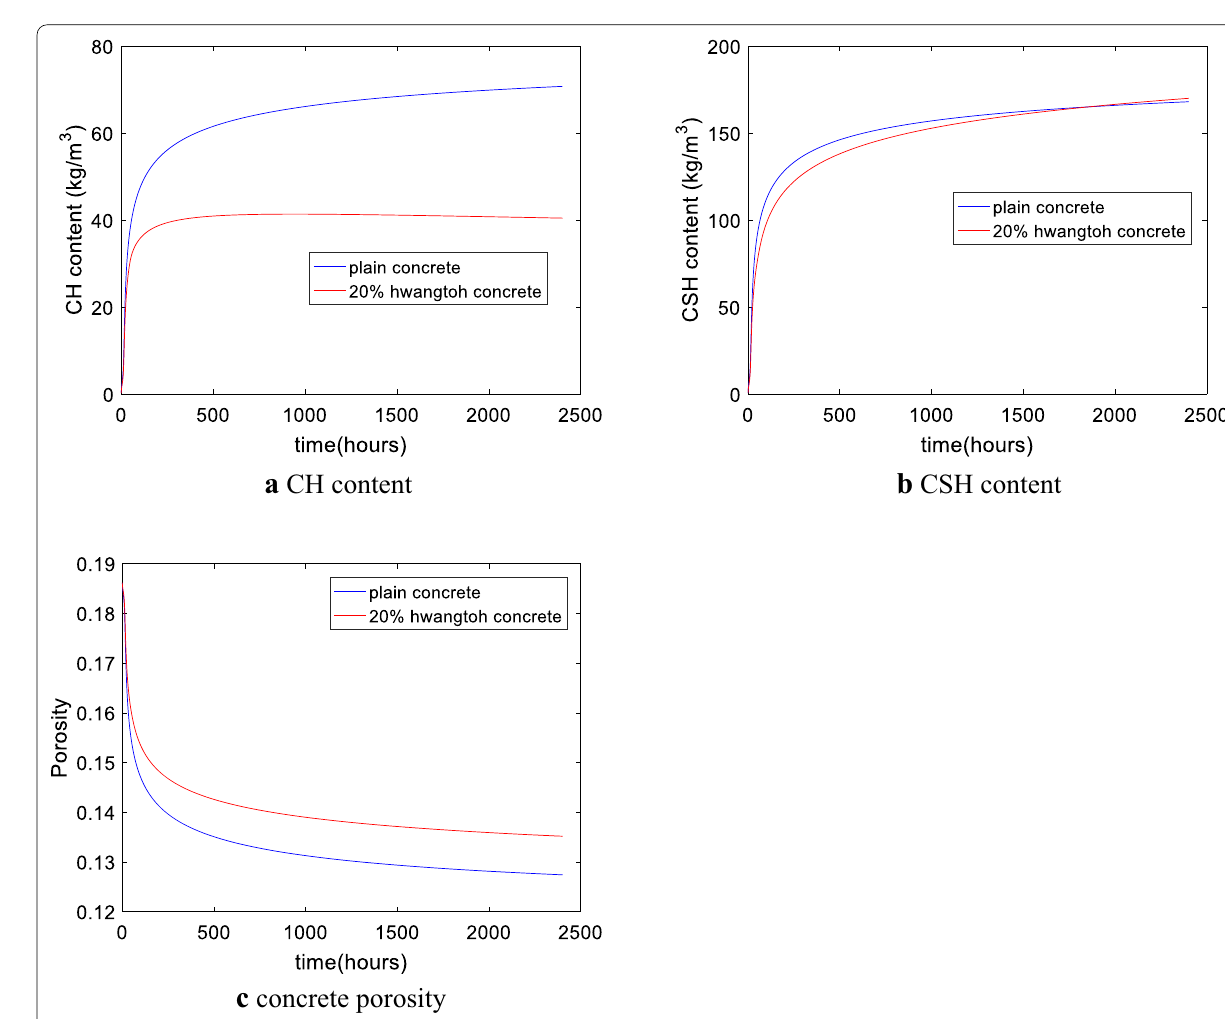
Fig. 9 Contents of carbonated substance and